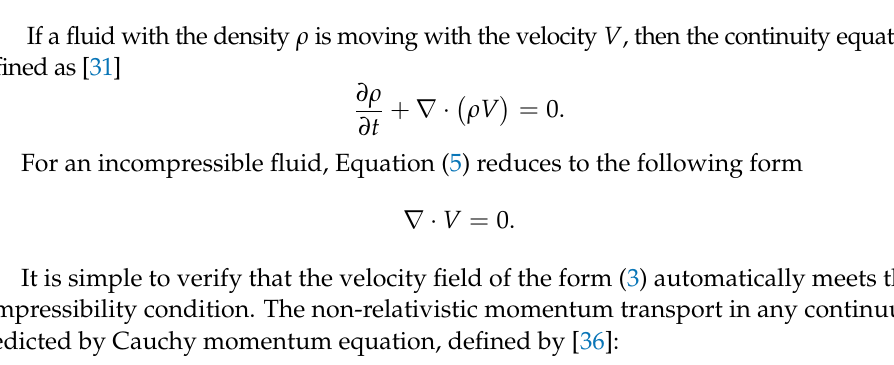
Figure 1. Graphical representation of the flow